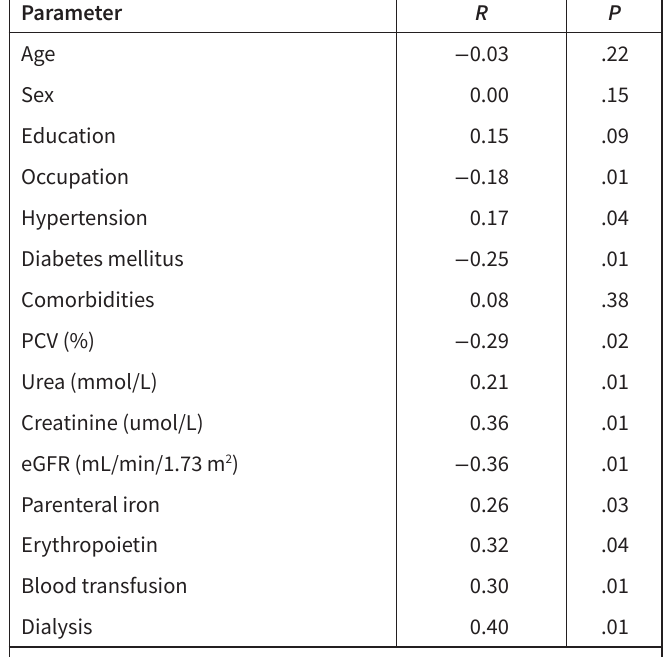
Table 4. Gender Distribution of Neuropsychiatric Manifestations Characteristics